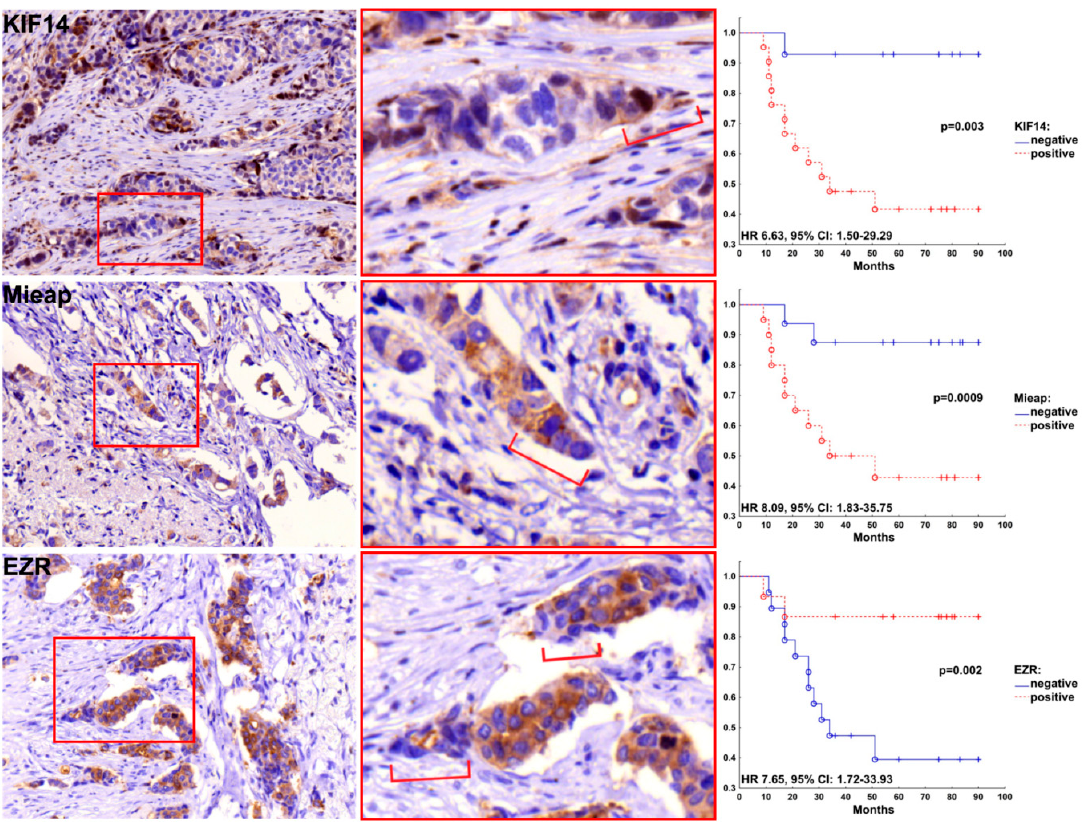
Figure 2. Metastasis-free survival rates of patients with the expression of KIF14, Mieap, and EZR at the tips of the torpedo-like structures in breast tumors. Hematoxylin and Eosin-stained images with 400× magnification.